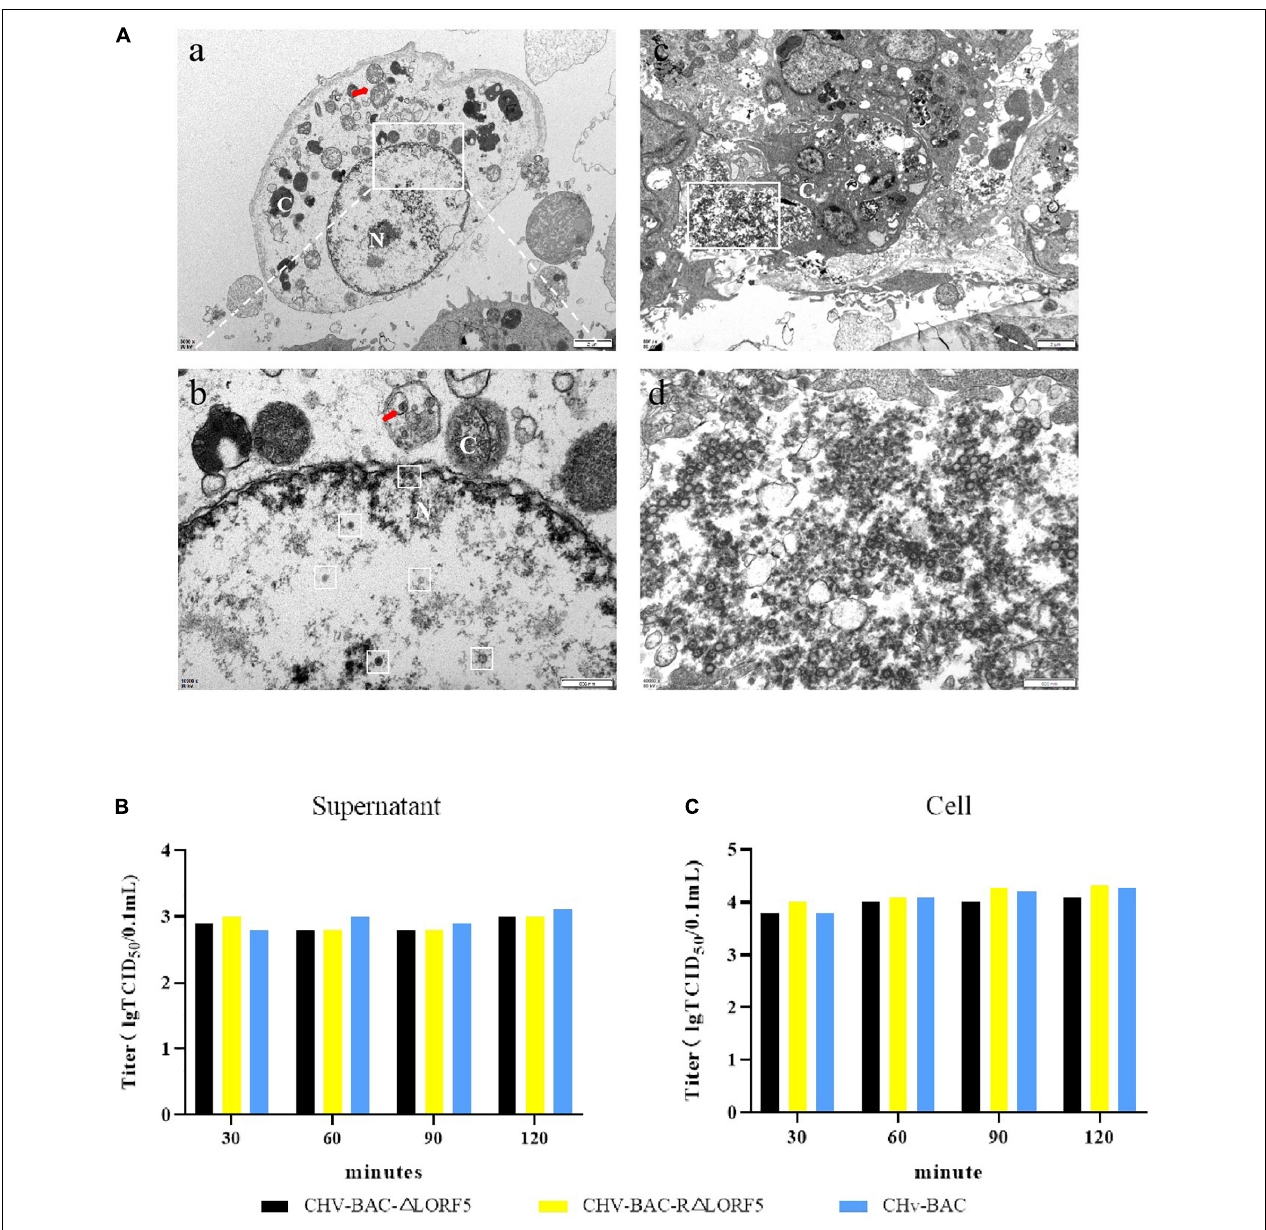
FIGURE 5 | The role of LORF5 in the assembly and release of virus particles. (A) Electron microscopy analysis of DEF cells infected with CHv-BAC- (cid:49) LORF5. DEF cells were infected with 5 MOI of virus and examined by electron microscopy analysis (N, nucleus; C, cytoplasm). The white box in the middle indicates virus particles. (B) Eighteen hours after the cells were infected with the viruses, the medium was replaced with 2% maintenance solution; the supernatant was collected at 30, 60, 90, and 120 min after changing; and the infectious mature virus particles in the supernatant were detected. (C) At the same time, the cells were used as control. The means and standard deviations were measured with GraphPad Prism 8. Standard deviations are shown by error bars.